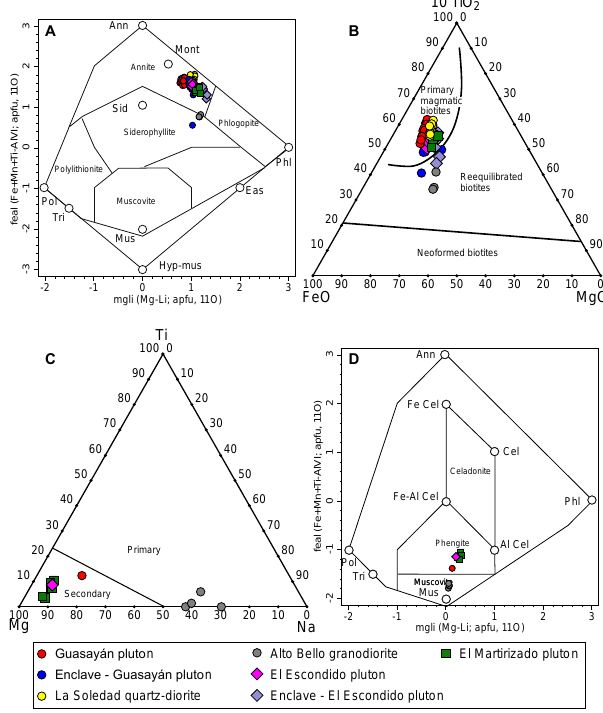
Figure 6. Composition of micas from the granitoids of the Sierra de Guasayán. ( A ) Feal vs. mgli diagram (after [71]). ( B ) 10 TiO 2 –FeO–MgO ternary diagram from [72]. ( C ) Atomic Ti–Na–Mg diagram with compositional fields for primary and secondary micas from [73]. ( D ) Feal vs. mgli diagram for white mica (after [70]). Abbreviations: Ann, annite; Cel, celadonite; Eas, eastonite; Hyp-mus, hyper-muscovite; Mus, muscovite; Mont, montdorite; Phl, phlogopite; Pol, polylithionite; Sid, siderophyllite; Tri,